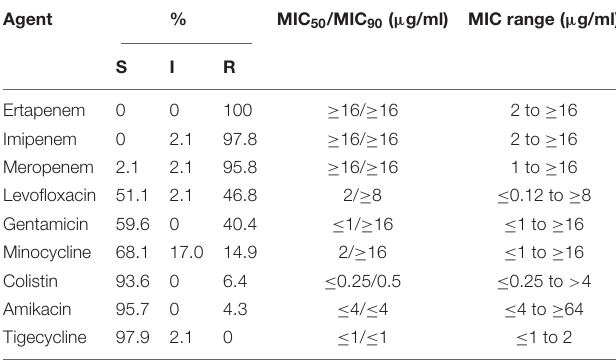
TABLE 2 | Antimicrobial susceptibilities of the 47 NDM-producing isolates carrying IncX3 plasmids.